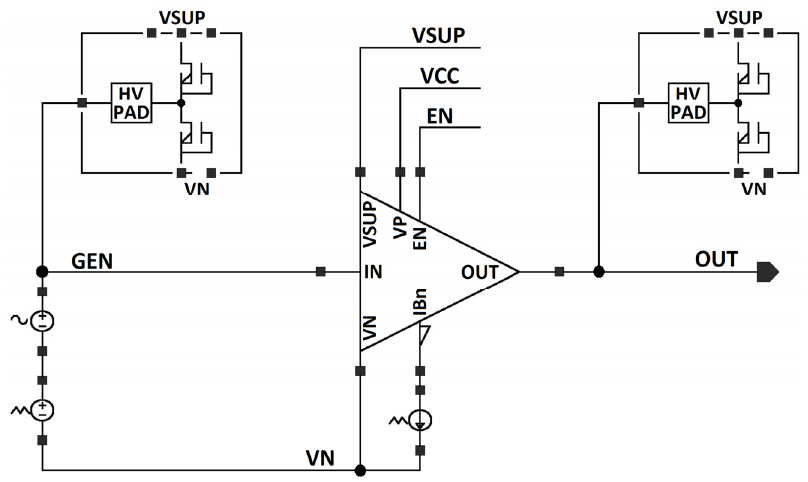
Figure 12. Simulation setup for comparison of the buffer implementation stages.